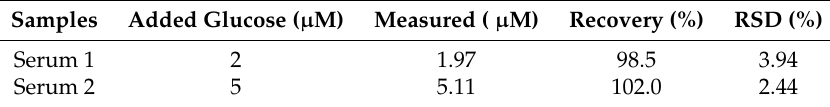
Table 2. Glucose determination in dilute serum samples ( n =